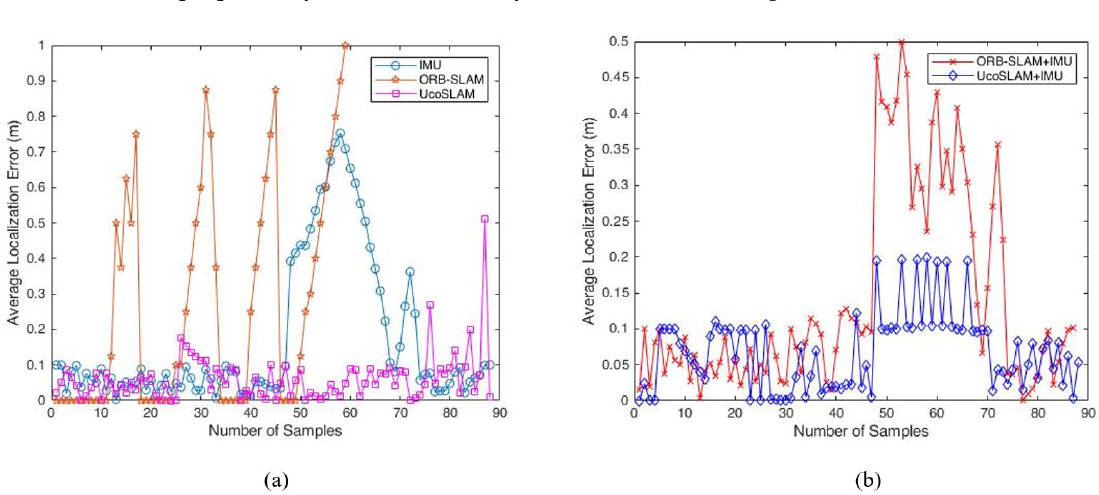
Figure 6. Average localization error. ( a ) IMU-based localization, camera based localization ( b ) Proposed hybrid localization